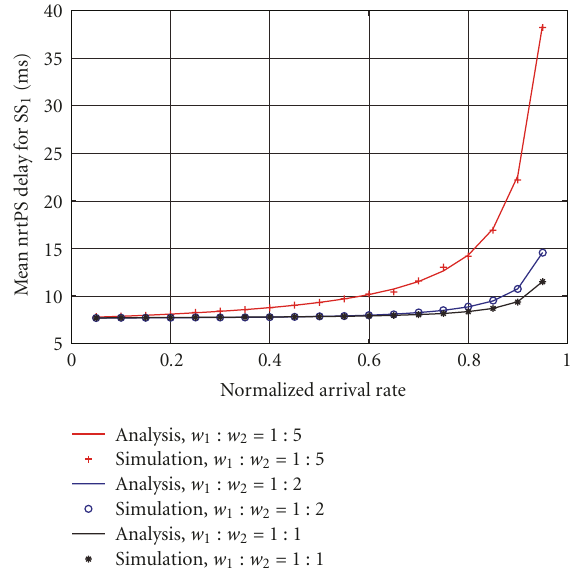
Figure 10: Mean nrtPS packet delay at SS 1 in asymmetric system ( N = 2).